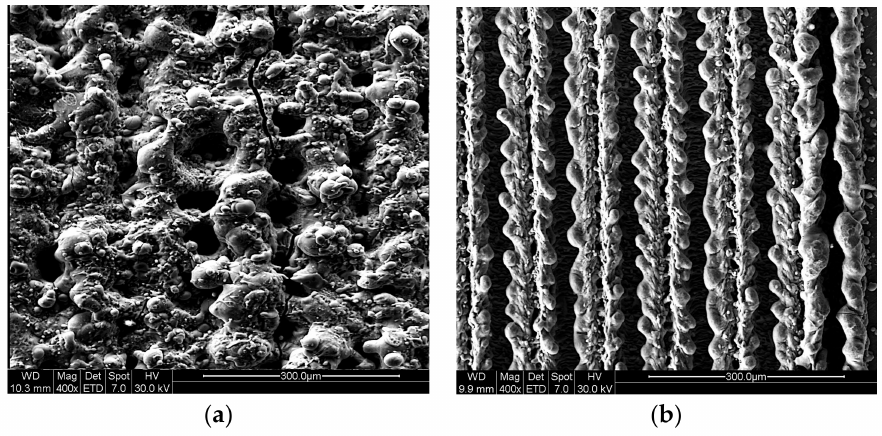
Figure 2. Surface topographies’ evolution as a function of the scan speed of the beam ( a ) V s = 10 mm/s; ( b ) V s = 200 mm/s.